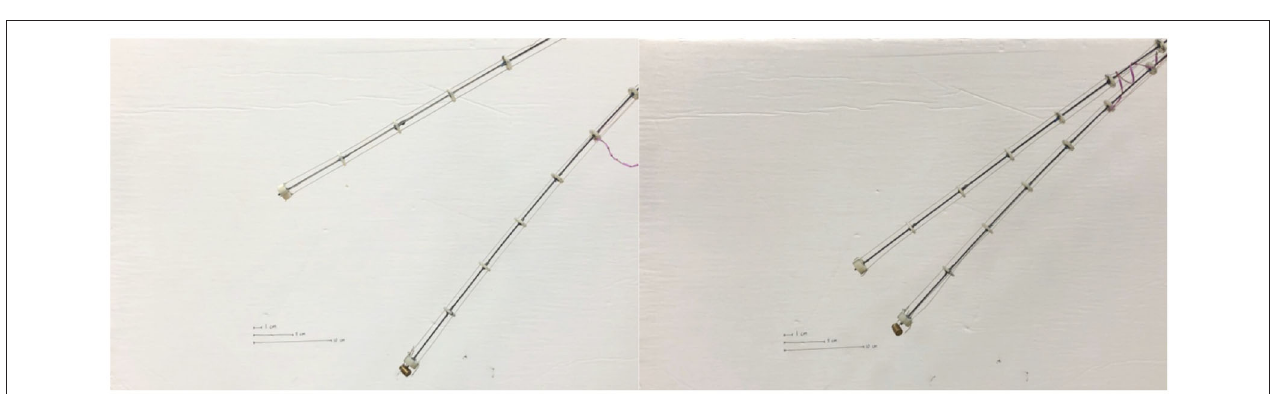
FIGURE 11 | Robot tendril using SMA searcher to braid with a parallel tendril.